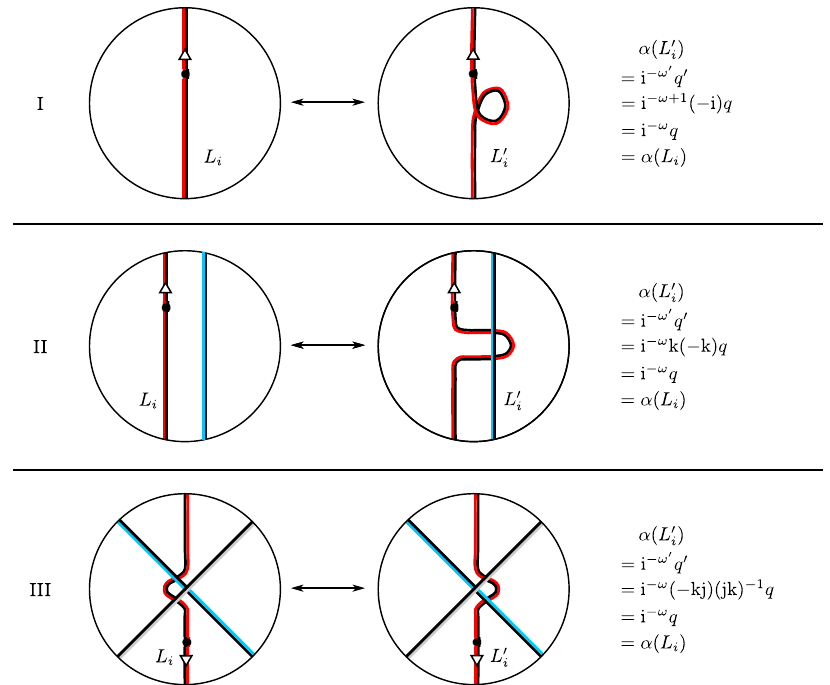
Fig. 9 Examples of Q 8 -colored Reidemeister moves, and the conservation of the colored invariants Q c . The Reidemeister moves do not affect the pairwise modulo-two linking numbers between loops of the same color, and therefore it is enough to verify that the α -invariant of the modi fi ed loop remains